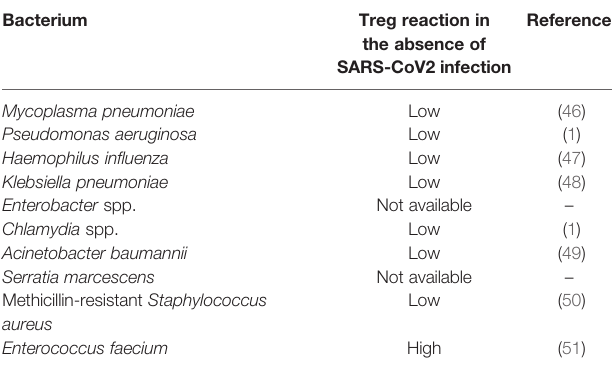
TABLE 2 | Bacterial co-infections in COVID-19 patients (in a descending order of their prevalence) (45) and Treg reaction to the bacteria in the absence of SARS-CoV2.